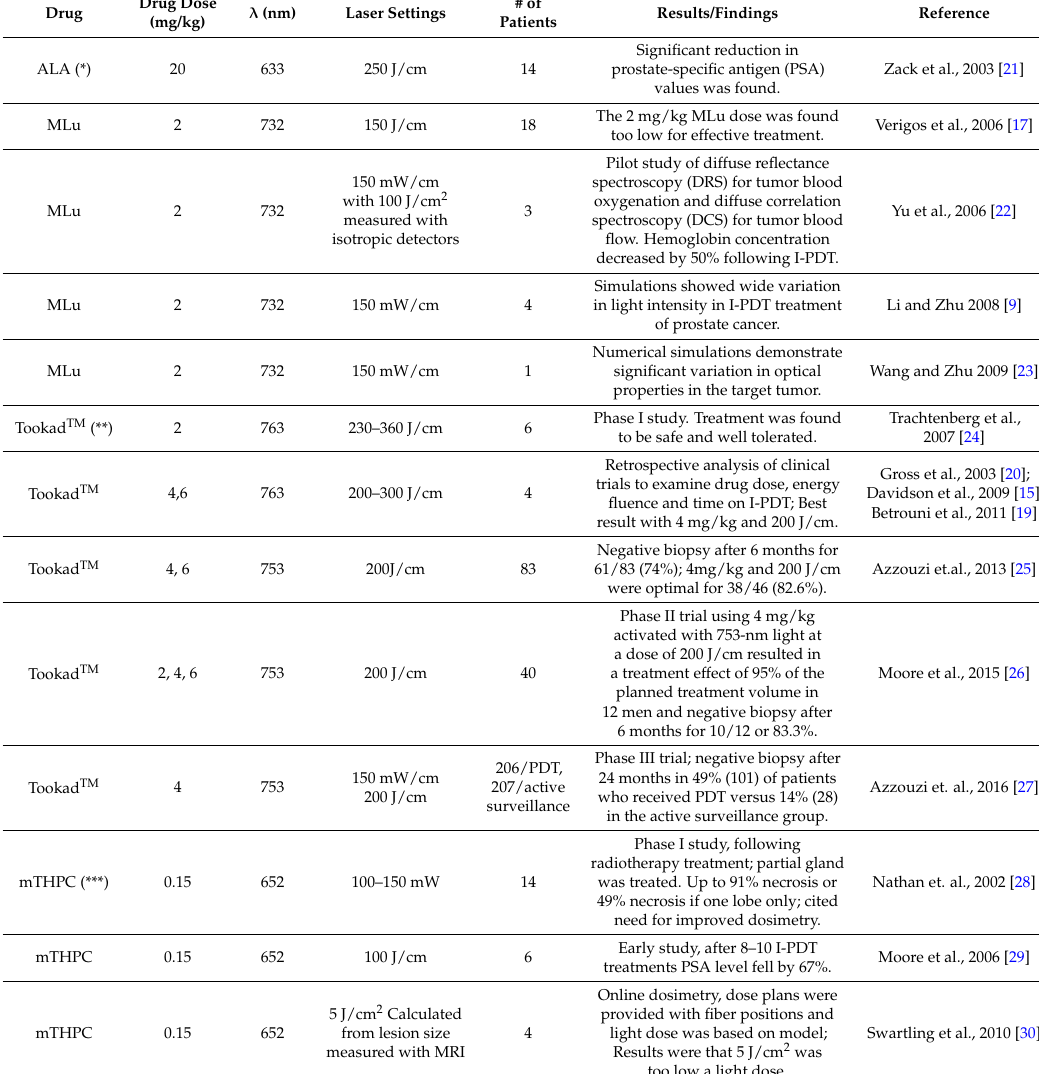
Table 1. Table of representative photosensitizer (PS), light wavelengths and energy/intensity, number of subjects and general findings for interstitial photodynamic therapy (I-PDT) prostrate treatment. * approved in the US and EU for actinic keratosis, ** approved in Mexico for treating early-stage prostate cancer, *** approved in the EU for treating head and neck cancer. ALA: 5-aminolevulinic acid; MLu: motexafin lutetium; mTHPC: meso-tetrahydroxyphenylchlorin. Drug Drug Dose (mg/kg) λ (nm) Laser Settings # of Patients Results/Findings Reference